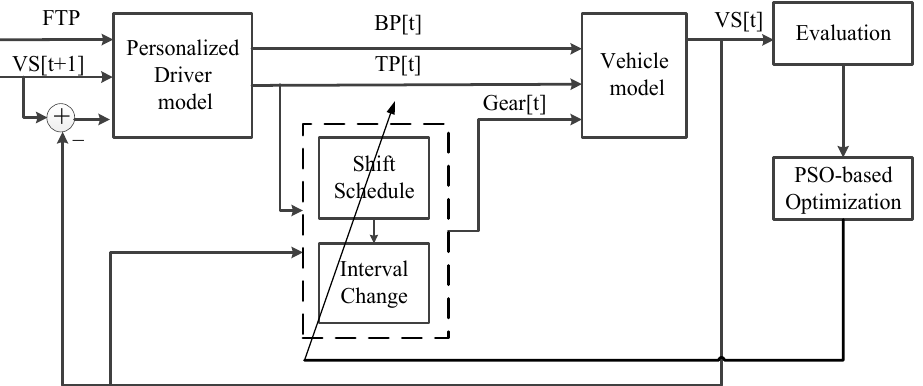
Figure 4. Block diagram of automated calibration system.